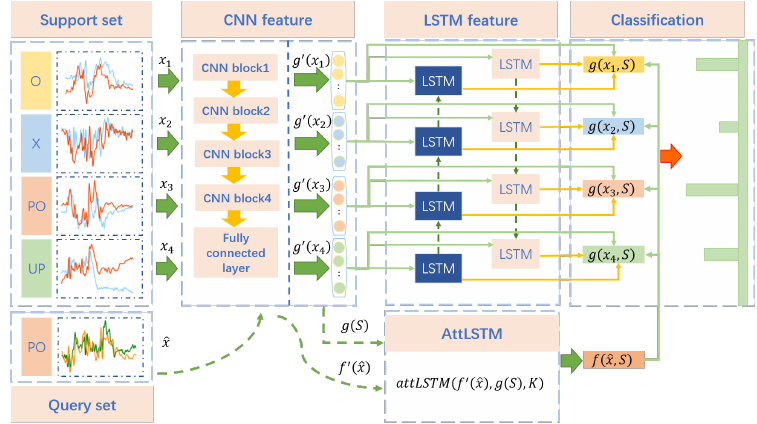
Figure 11. The architectures of human activity recognition method.